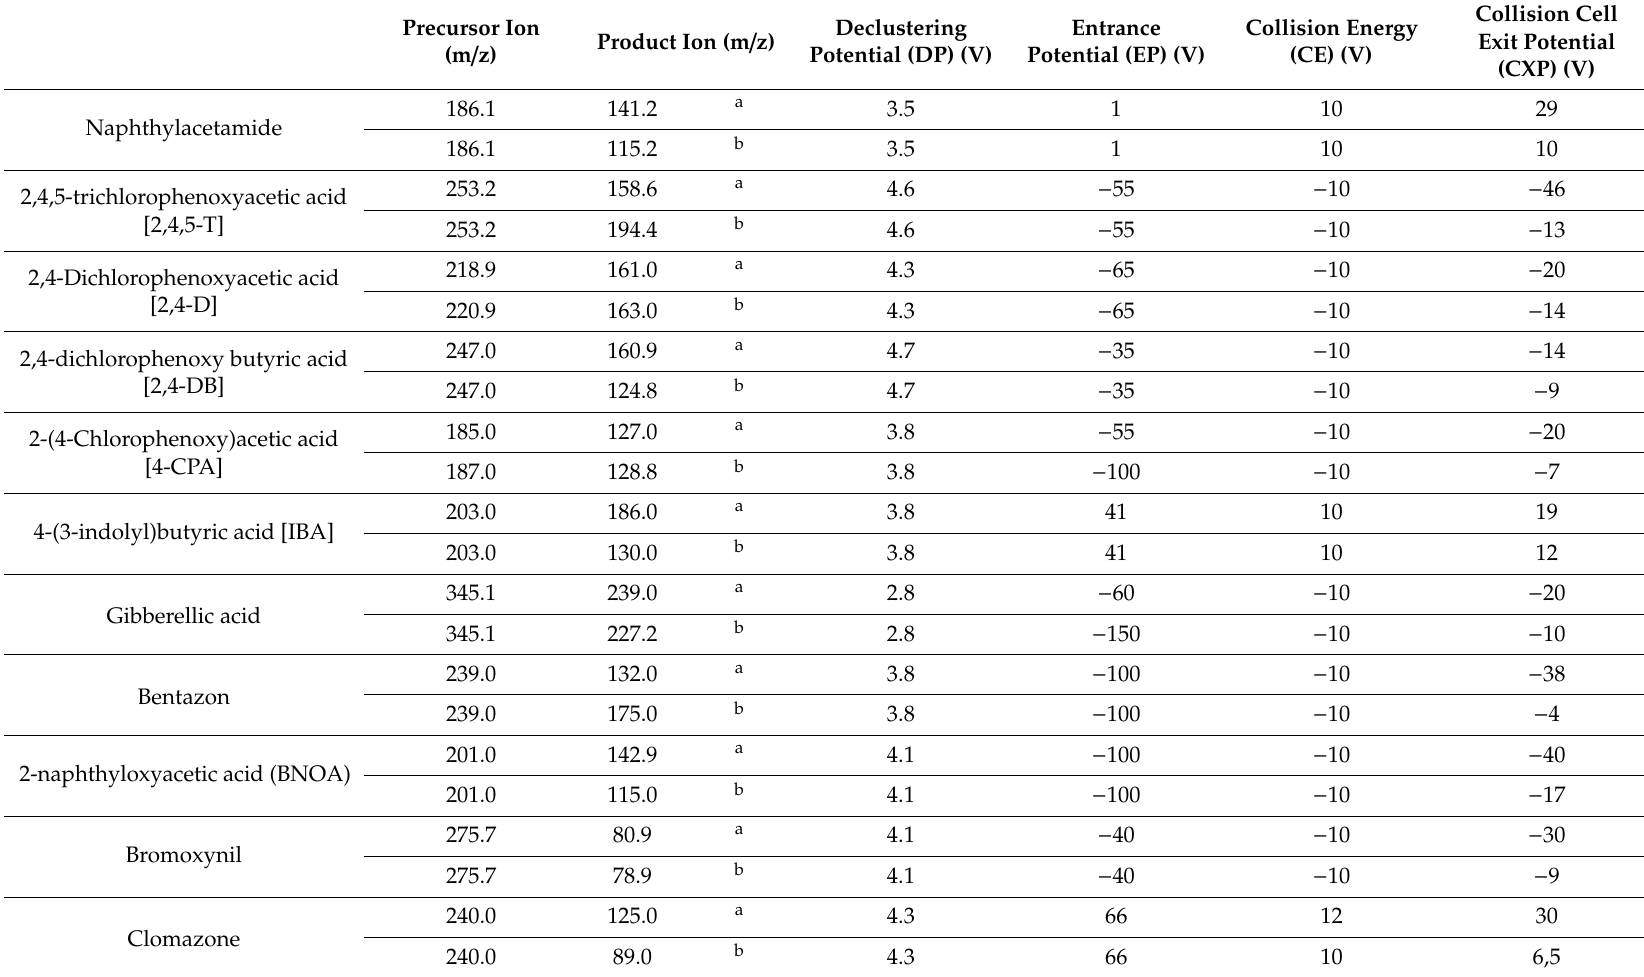
Table 1. Shows the specific detection conditions for each